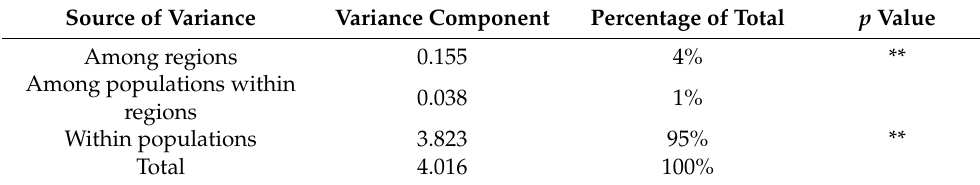
Table 5. AMOVA of 203 samples from eight T. sebifera populations. Source of Variance Variance Component Percentage of Total p Value Among regions 0.155 4% ** Among populations within 0.038 1% regions Within populations 3.823 95%